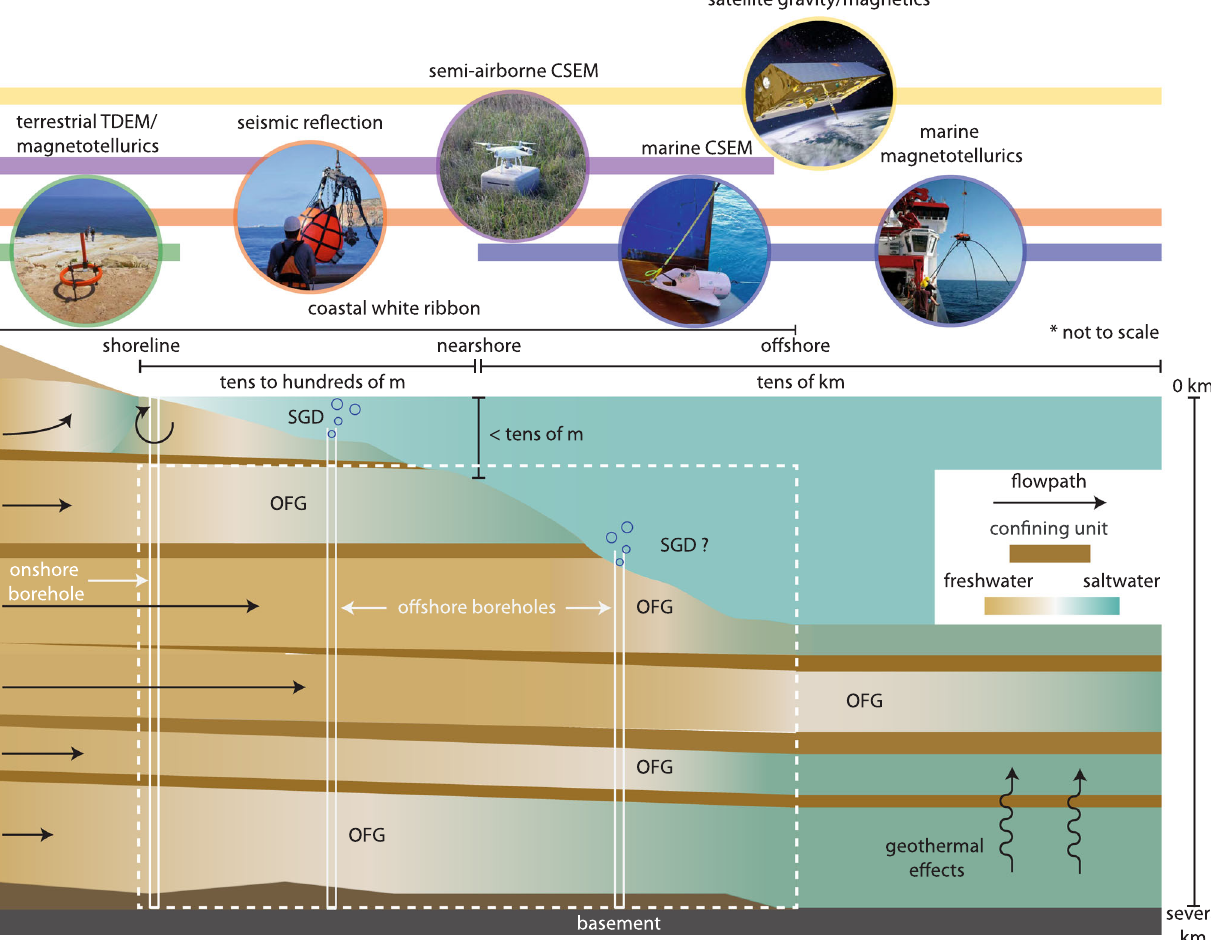
Fig. 2 Geophysical methods connecting onshore-offshore groundwater systems. Conceptual diagram depicting multi-layer groundwater reservoirs and their respective simpli fi ed fl uid migration pathways beneath the coastal white ribbon. Offshore freshened groundwater and submarine groundwater discharge are abbreviated (OFG) and (SGD), respectively. The area of interest for deep exploration geophysics, boreholes, and groundwater modeling in shallow coastal waters is outlined by the white dashed lines. Existing geophysical methods for deep groundwater exploration crossing the white ribbon and their respective zones of coverage are indicated by the colored bars intersecting the middle of each image. All images in the bubbles are owned by the authors except the satellite gravity/magnetics image “ Courtesy NASA/JPL-Caltech ”